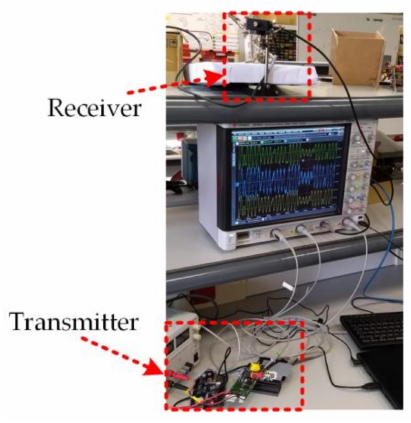
Figure 17. VLC setup transmitting the test sequence (the link distance is around 1